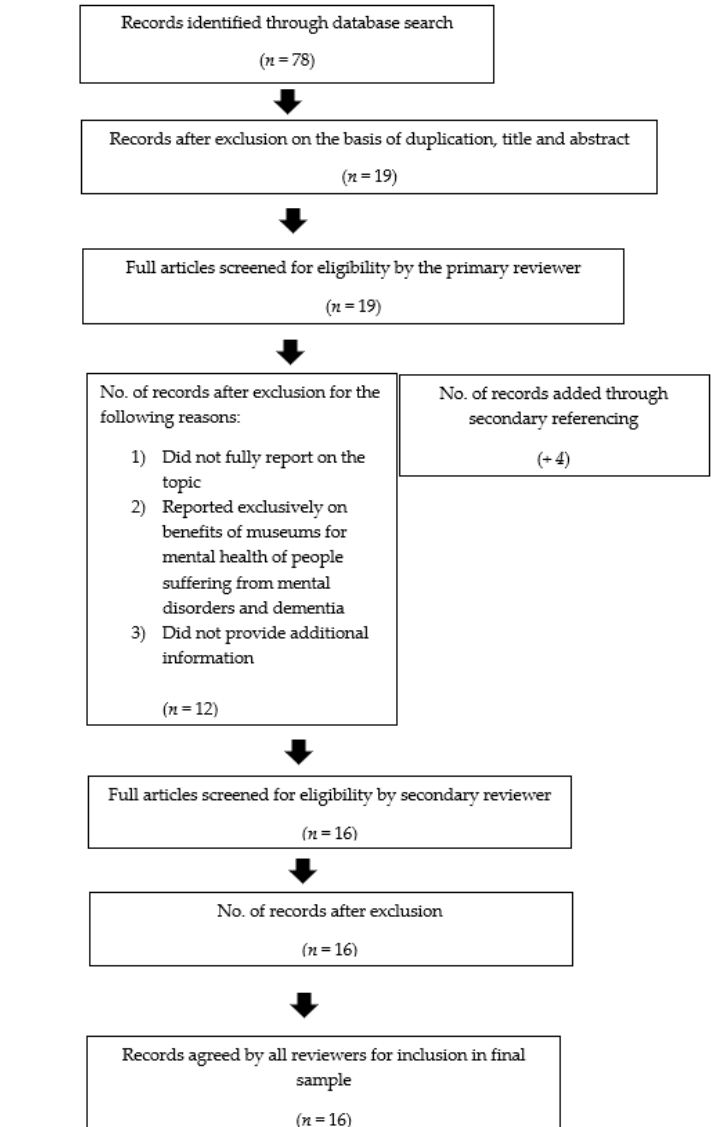
Figure 1. The PRISMA flow.